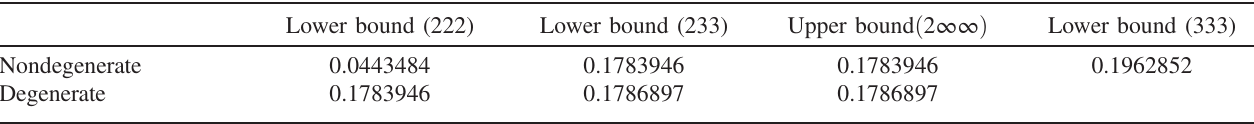
TABLE III. Qubit lower and upper bounds for different local dimensions on the violation of the I 3 ; 3 ; 3 inequality computed using a seesaw search and SDP computation. The qutrit value (333) is the overall quantum maximum as certified by the NPA hierarchy. The upper-bound value for the nondegenerate case was computed using the technique of Sec. IIIB, whereas the upper-bound value for the degenerate case was obtained by the NPA hierarchy. Lower bound (222) Lower bound (233) Upper bound ð 2 ∞∞ Þ Lower bound (333) Nondegenerate 0.0443484 0.1783946